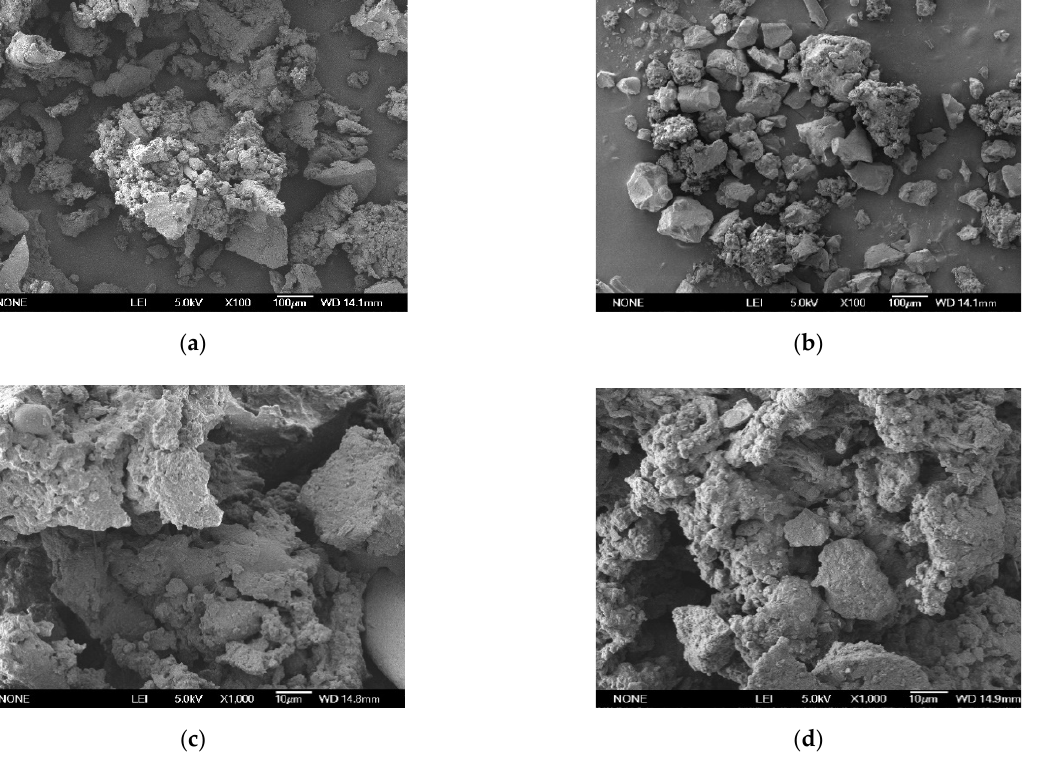
Figure 1. Scanning electron microscopy (SEM) images. ( a ) unactivated rubber (×100 magnification); ( b ) microwave activated (×100 magnification); ( c ) unactivated rubber (×1000 magnification); ( d ) mi ‐ tion); ( b ) microwave activated ( × 100 magnification); ( c ) unactivated rubber ( × 1000 magnification); crowave activated (×1000 magnification). ( d ) microwave activated ( × 1000